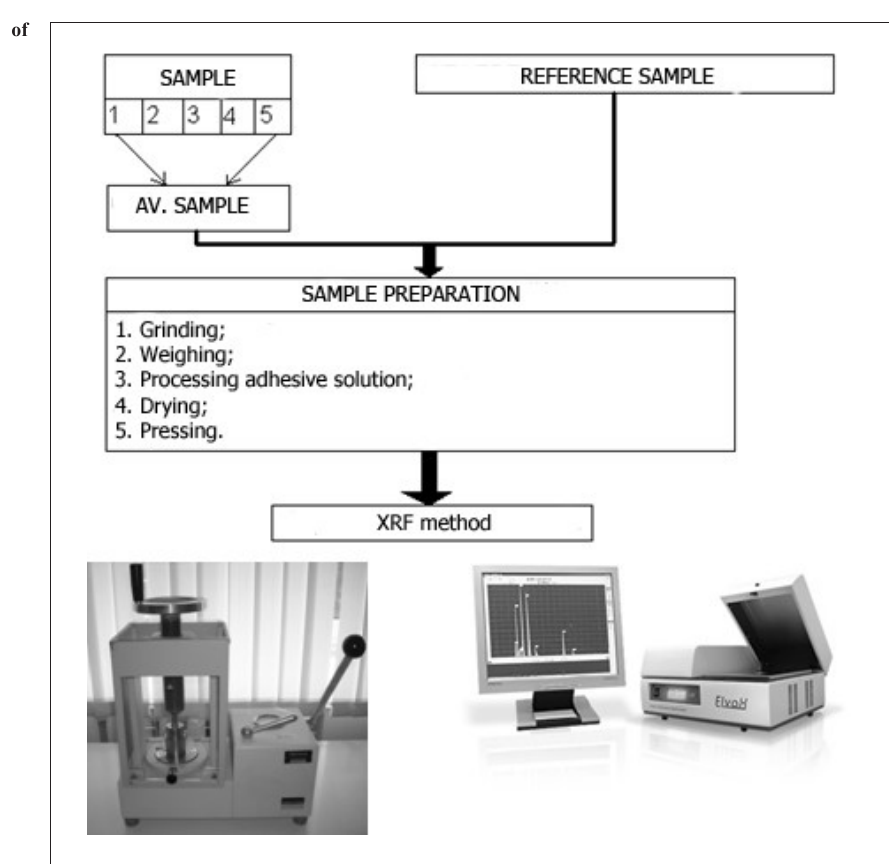
Figure. XRF method. Stages